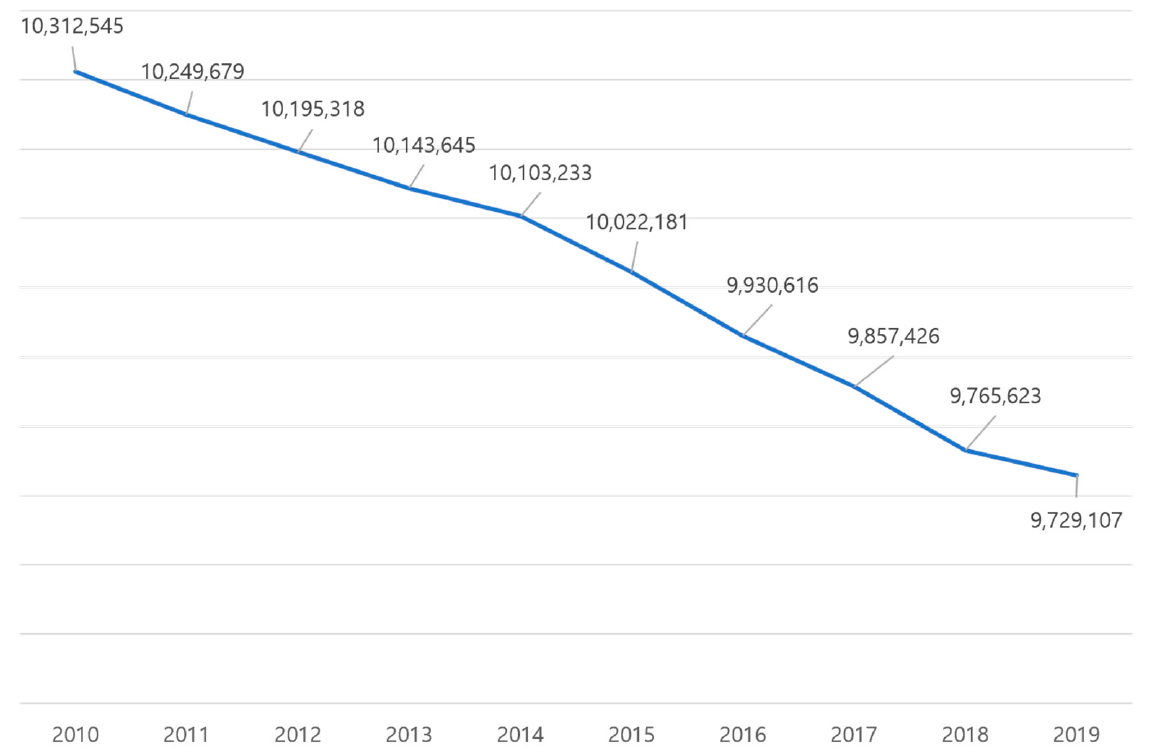
Figure 1. Population changes in Seoul (Source: 2010–2019 Population Census by Statistics Korea).